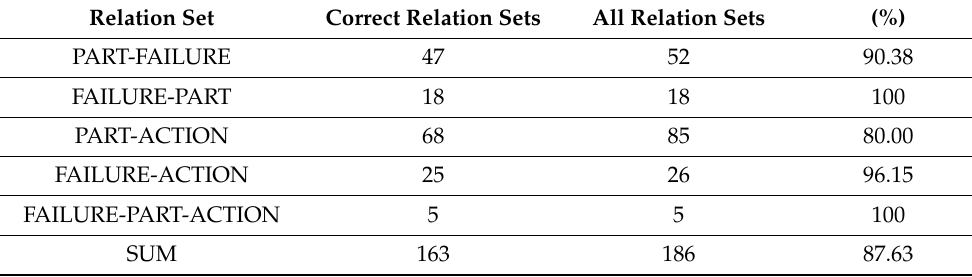
Table 10. Relation set recognition